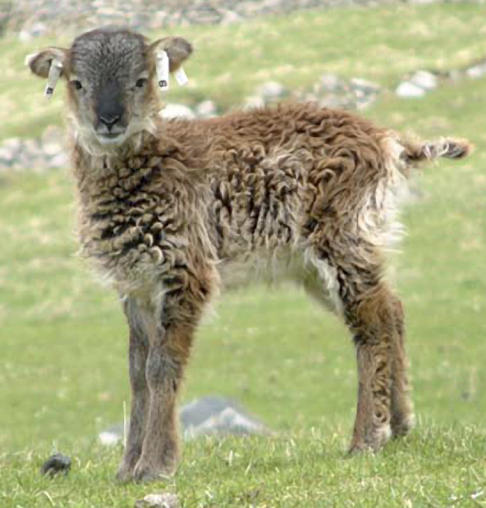
A Soay sheep lamb on the Scottish island of Hirta.